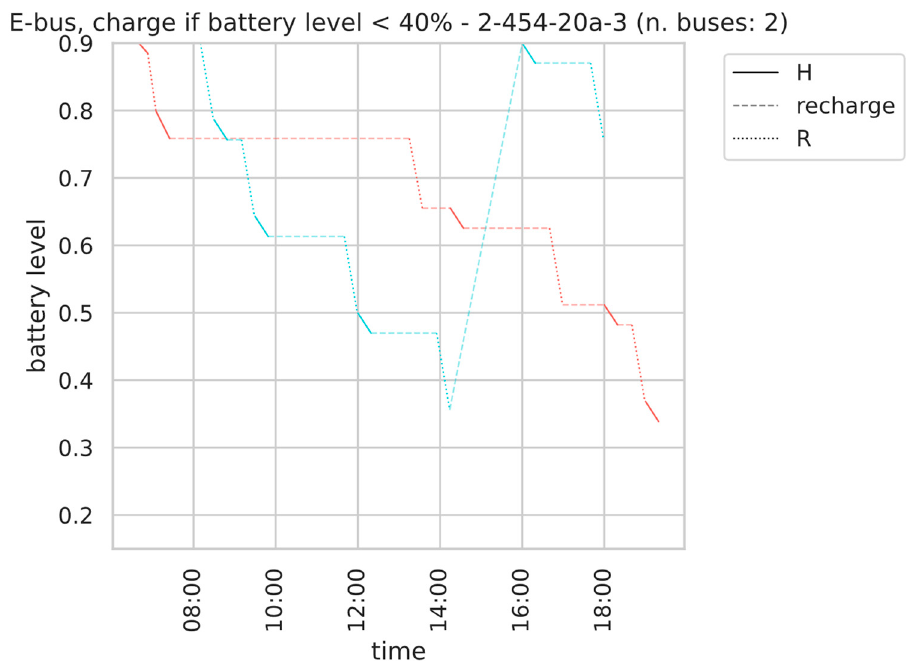
Figure 6. An example of the state of charge of a bus during the day travelling a specific line is shown. Each color represents a bus, the different line styles represent the bus status: the continuous line is the bus that is going to its destination (H), the dotted line is the bus that is on its way back to the origin (R), and dashed line is the bus that is waiting and/or recharging (recharge).